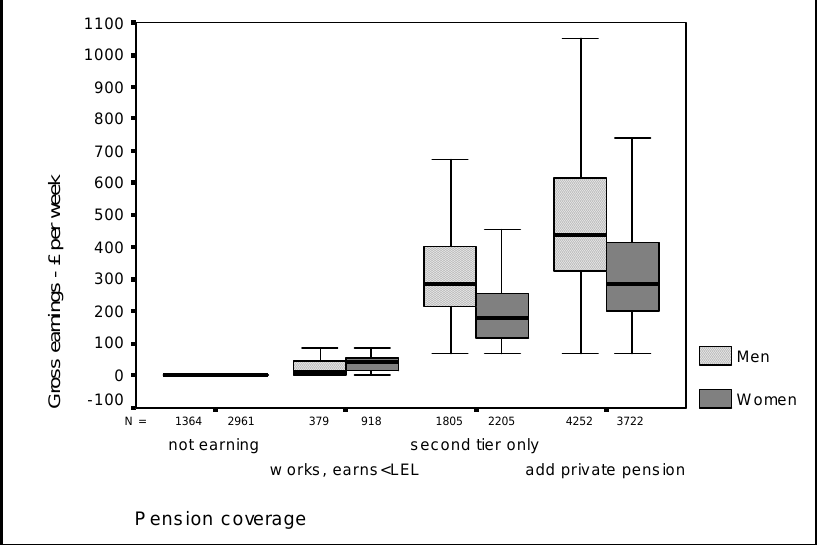
Figure 2. Distribution of earnings (£ per week) according to sex and type of pension contribution: men and women aged 20 to